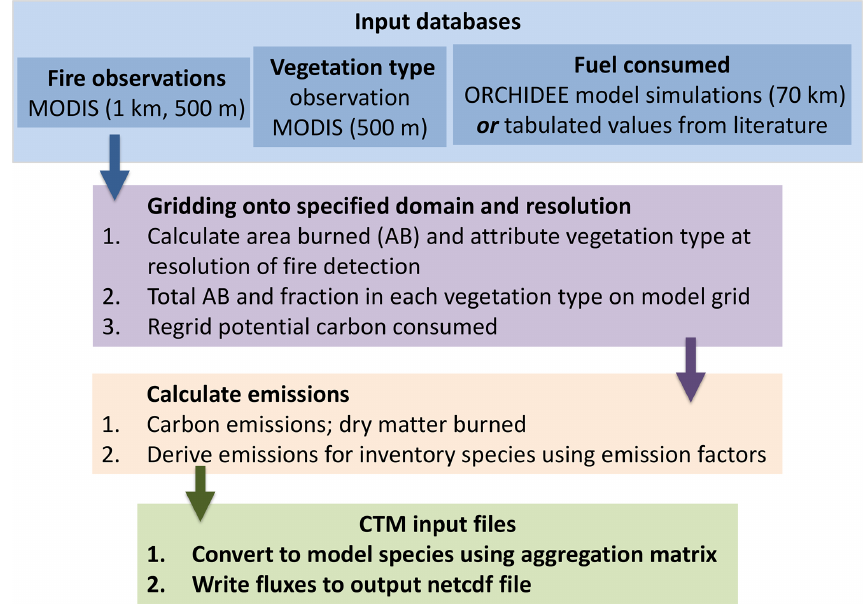
Figure 1. Overview of the APIFLAME v2.0 emissions